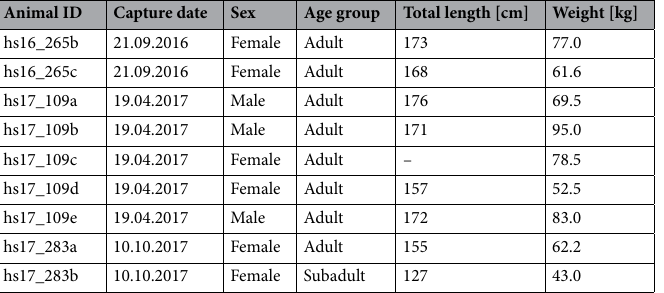
Table 1. Overview of nine harbour seals ( Phoca vitulina ) captured in the German Wadden Sea and instrumented with DTAGs in 2016 and 2017.